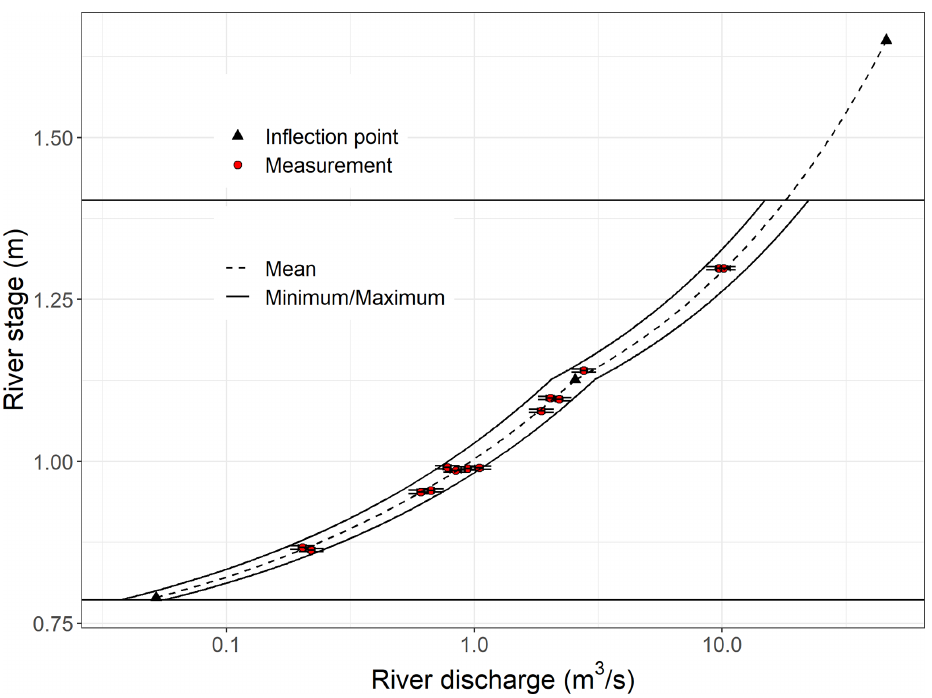
Figure 3. Stage–discharge rating curve (discharge was log10 transformed). The horizontal lines represent the range of river stages monitored during the study period.